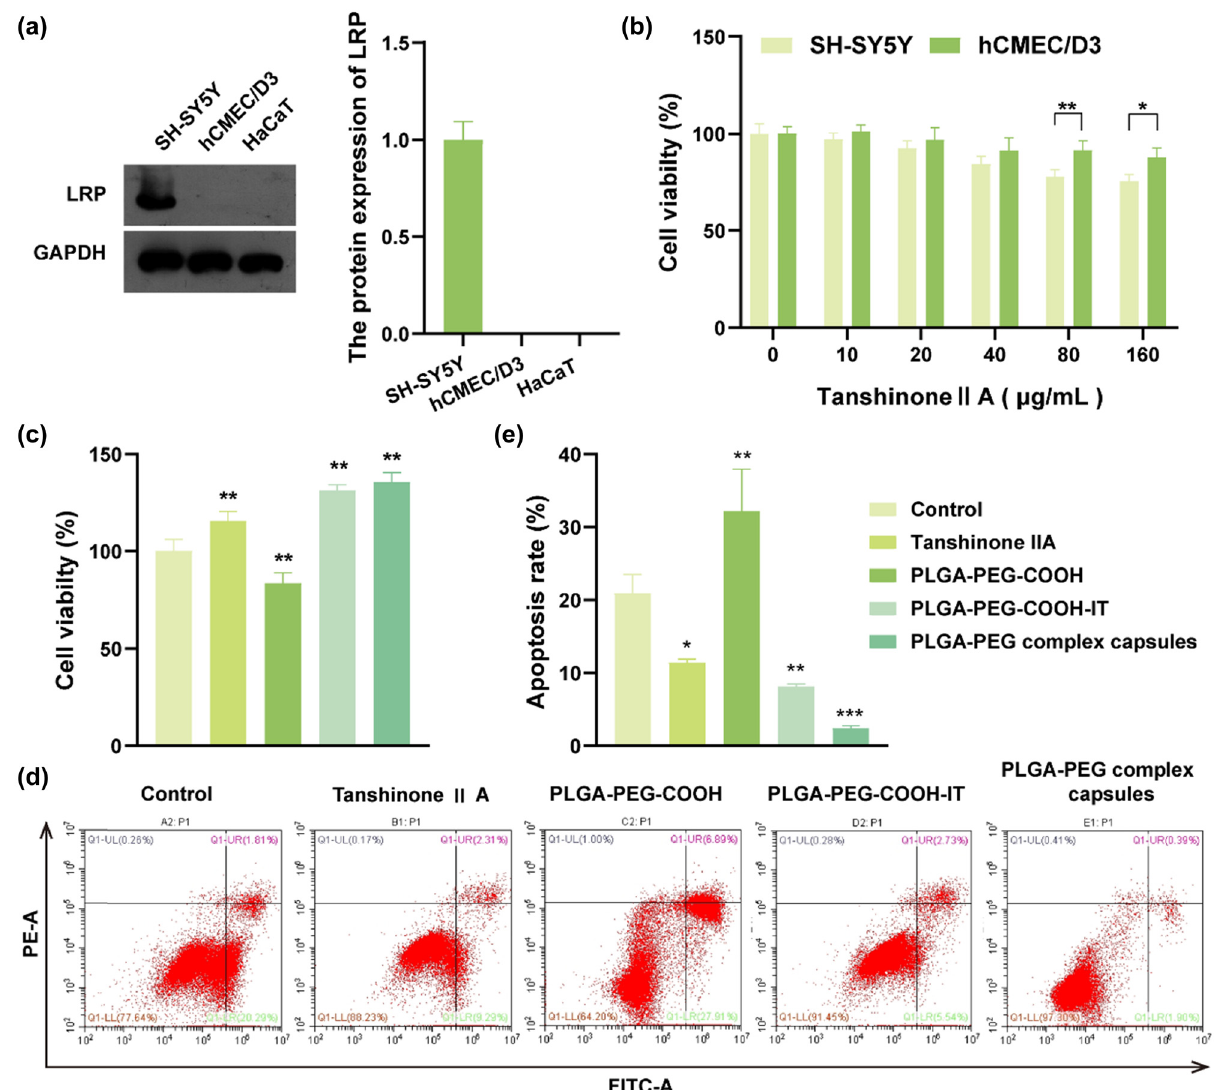
Figure 2: WB, cell viability, and apoptosis test in vitro . ( a ) LRP expressions in SH - SY5Y, hCMEC/D3, and HaCaT cells. ( b ) E ff ect of PLGA - PEG complex capsules with di ff erent dosages on SH - SY5Y and hCMEC/D3 cell viability ( n = 4, mean ± SD, * P < 0.05, ** P < 0.01 ) . ( c ) E ff ects of di ff erent treatment groups on SH - SY5Y/IR cell viability co - incubated with nanoparticles before OGD/R treatment ( n = 4, mean ± SD, ** P < 0.01 ) . ( d and e ) Representative scatter plots and statistical histogram showing apoptosis in SH - SY5Y/IR cells by fl ow cytometry ( n = 3, mean ± SD, * P < 0.05, ** P < 0.01, *** P < 0.001 )